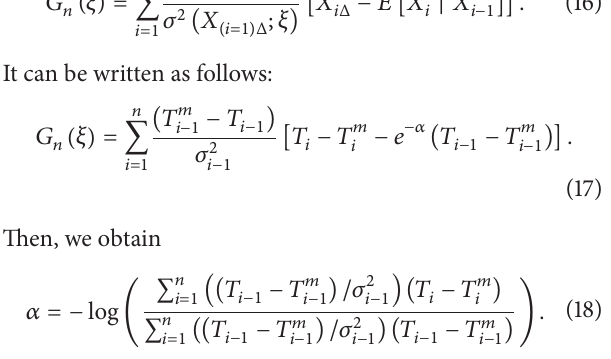
Figure 5: Data fitting of temperature (Zhengzhou,